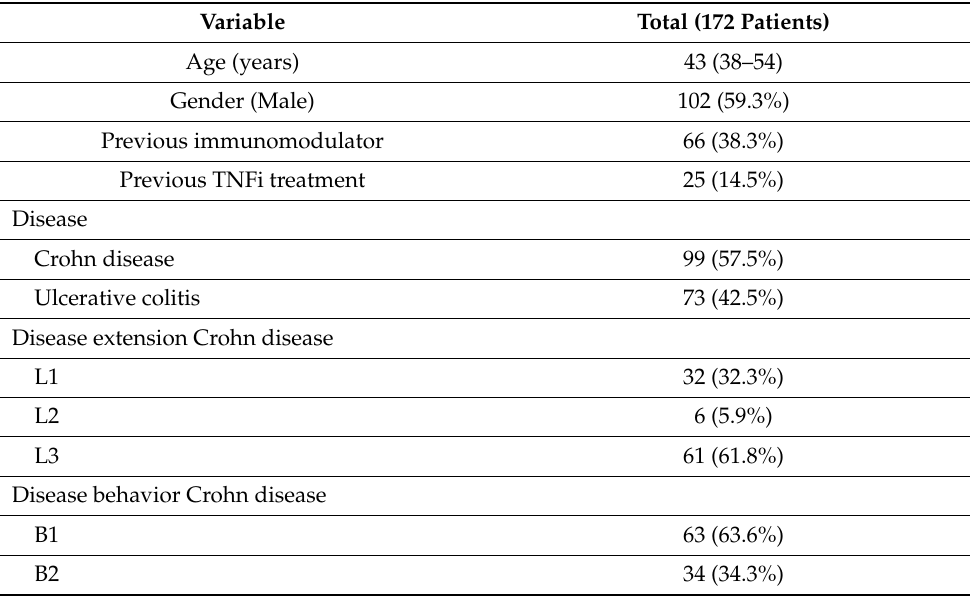
Table 1. Patients’ baseline